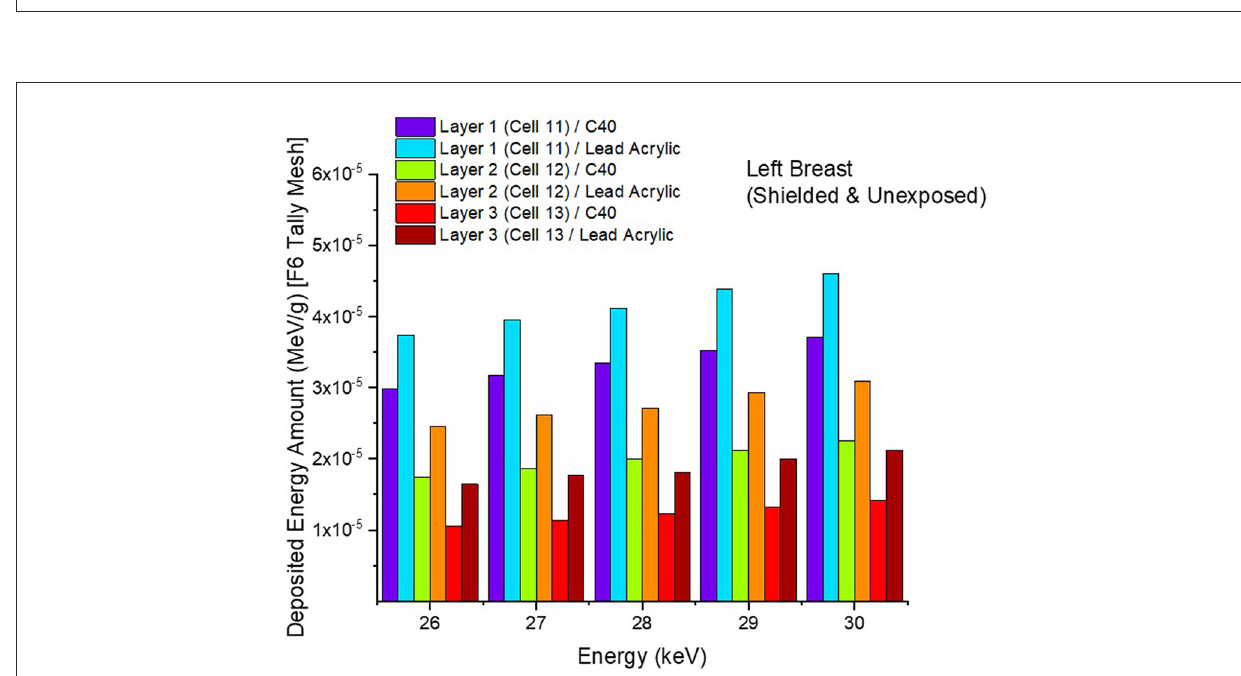
FIGURE10 Variation of deposited energy amount in the three breast layers for unexposed and protected left breast.